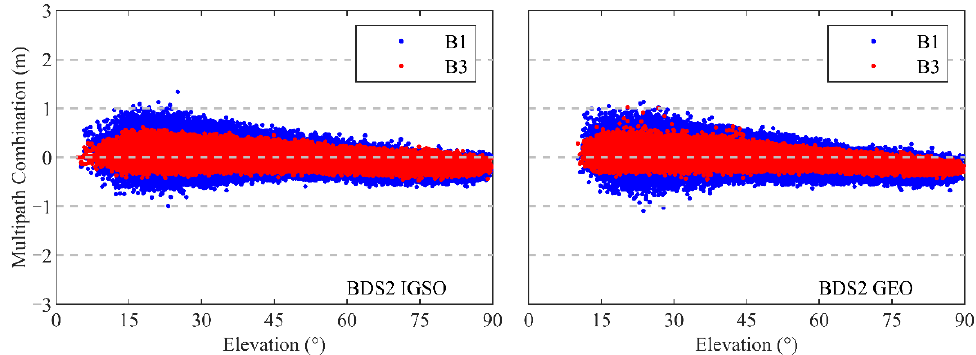
Figure 6. Multipath combinations of GPS and BDS2 pseudorange observations from TH-2A as a function of the elevation angle.